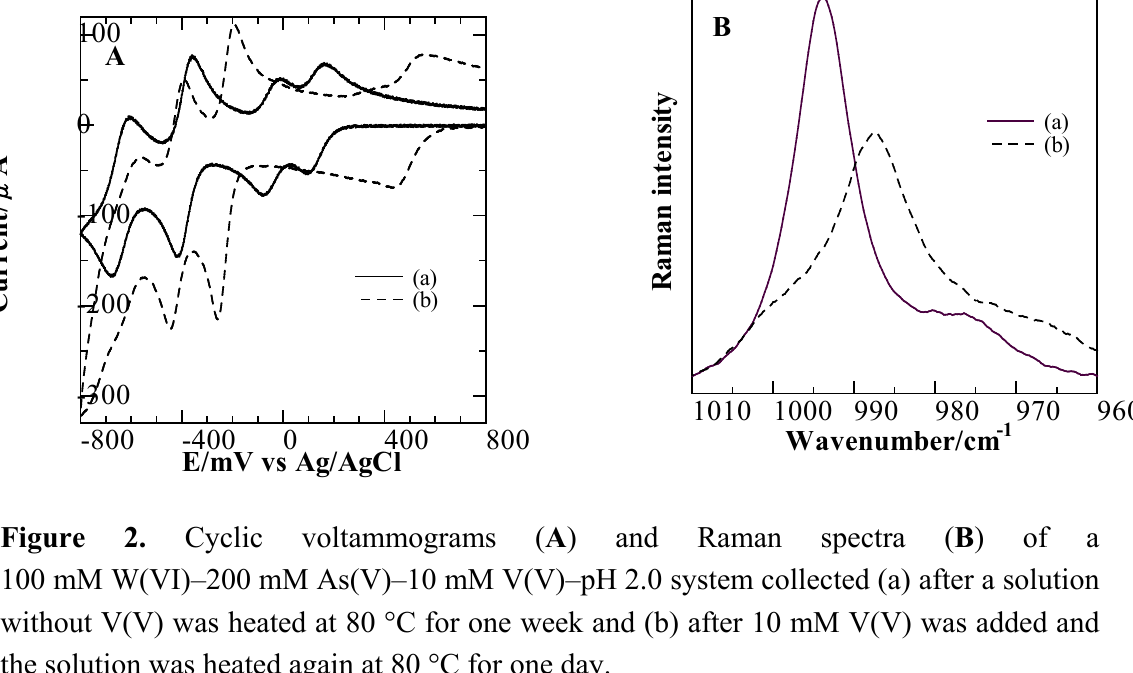
Figure 2. Cyclic voltammograms ( A ) and Raman spectra ( B ) of a 100 mM W(VI)–200 mM As(V)–10 mM V(V)–pH 2.0 system collected (a) after a